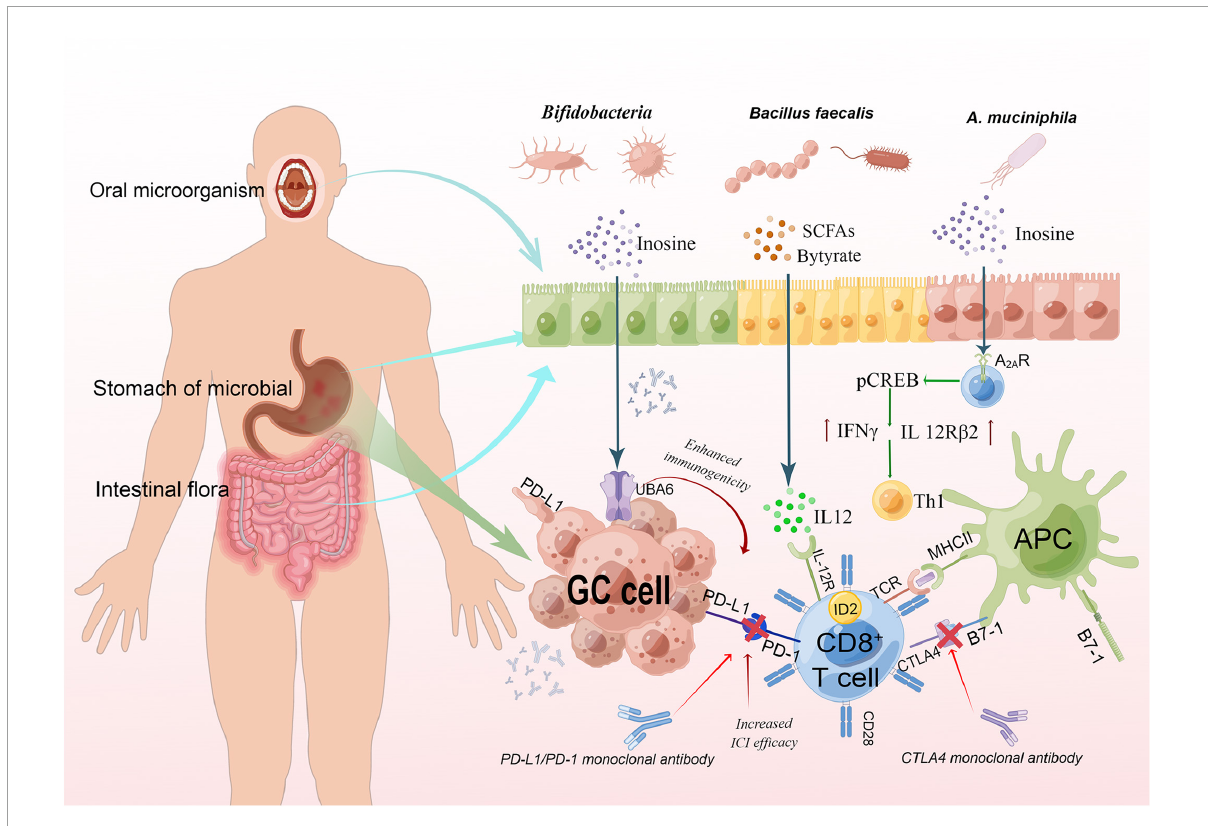
FIGURE2 The relationship between microbiota and immunosuppressive of GC. The interaction between TCR and peptide-MCHII on APC and a second costimulatory signal mediated by CD28 can activate T cells, while CTLA4 binds to B7-1 to inhibit the activation of T cells. Binding of PD-L1 on GC cells to PD-I on T cells can also inhibit T cell activation, so blocking the binding can activate T cells. Gastrointestinal bacteria were found to act synergistically. Butyric can induce CD8 + T cells to express ID2 through IL-12 signal transduction, and directly enhance the anti-tumor cytotoxicity of CD8 + T cells. Inosine could enhance ICI efficacy by acting on A2AR on T lymphocytes. It stimulates the phosphorylation of cAMP response element-binding protein (pCREB) through the inosine-A2AR-cAMP-PKA signaling pathway, which can upregulate IL12R β 2 and IFN γ transcription and promote Th1-cell differentiation and accumulation in the TME. This fig was made by Figdraw. TCR, T cell receptor; MHC, major histocompatibility complex; APC, antigen-presenting